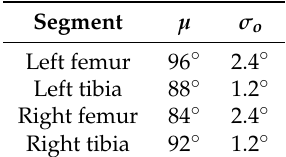
Table 1. Distribution of angle between the knee’s rotation axis and the leg segments according to Hollister et al. [84] for use in Equation (12), adapted for a right-pointing knee axis and proximal-pointing segment